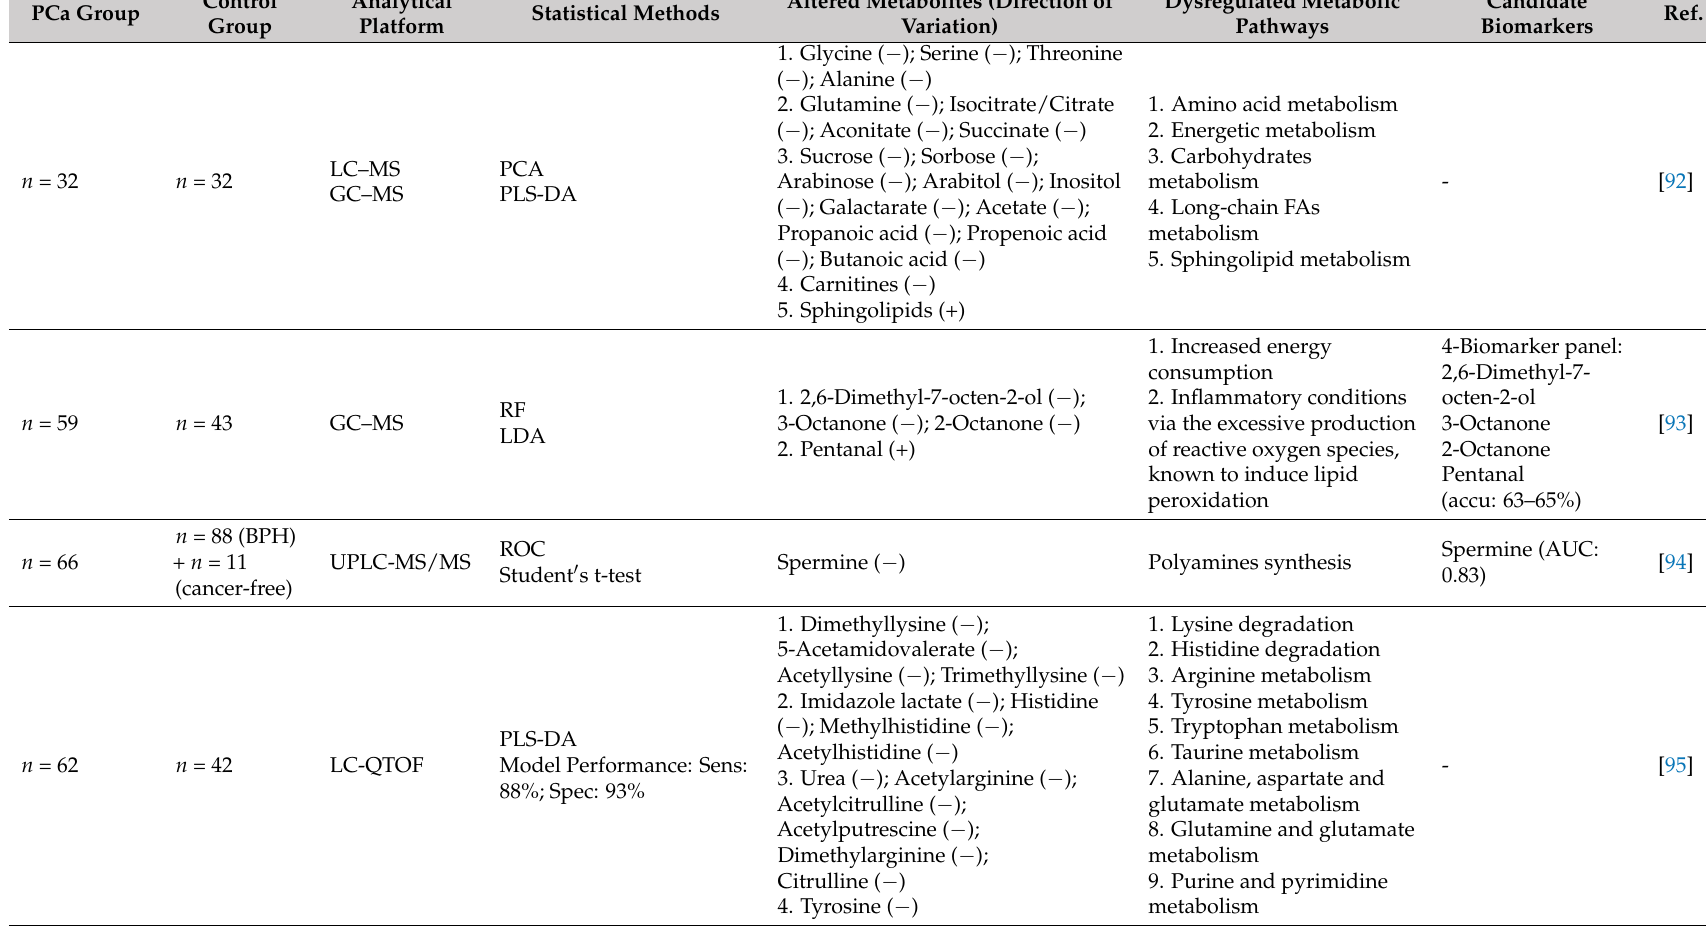
Table 3. Metabolomic studies performed in urine samples from PCa patients in the last 5 years